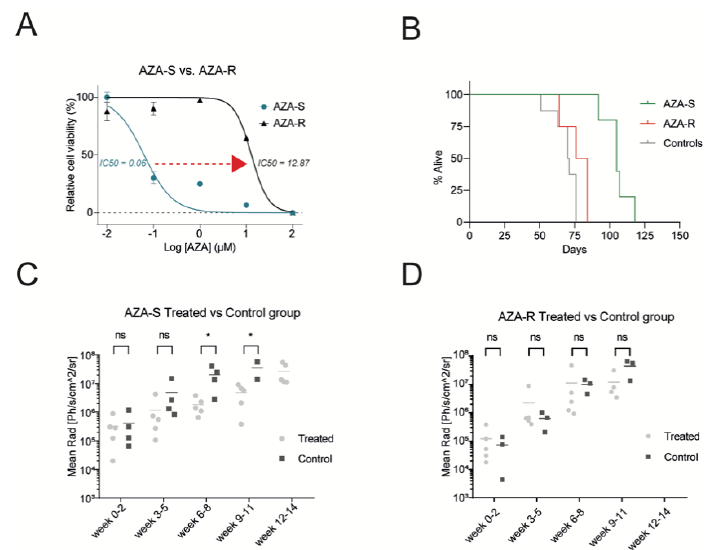
Figure 1. Analysis of the AZA resistance model. ( A ) WST1 assay of AZA-sensitive (S) vs. AZA- resistant (R) cells (clone #1); IC50 AZA is indicated. ( B – D ) AZA-S & AZA-R cells were transplanted into NSGS mice and treated with AZA or vehicle (Control). Therapy of 150 μ g AZA/mouse was applied i.p. three times weekly. Survival was monitored (days indicated, 4 or 5 mice per each group). AZA-S vs. AZA-R p = 0.004, AZA-S v Ctrl p = 0.0014, AZA-R vs. Ctrl p = 0.0953. ( C , D ) Luciferase detection ( y -axis Mean Rad) in control vs. AZA-treated mice bearing AZA-S (left) or AZA-R (right) xenograft cells. Analysis utilized unpaired Mann–Whitney t-test. * p -value < 0.05, ns not significant.